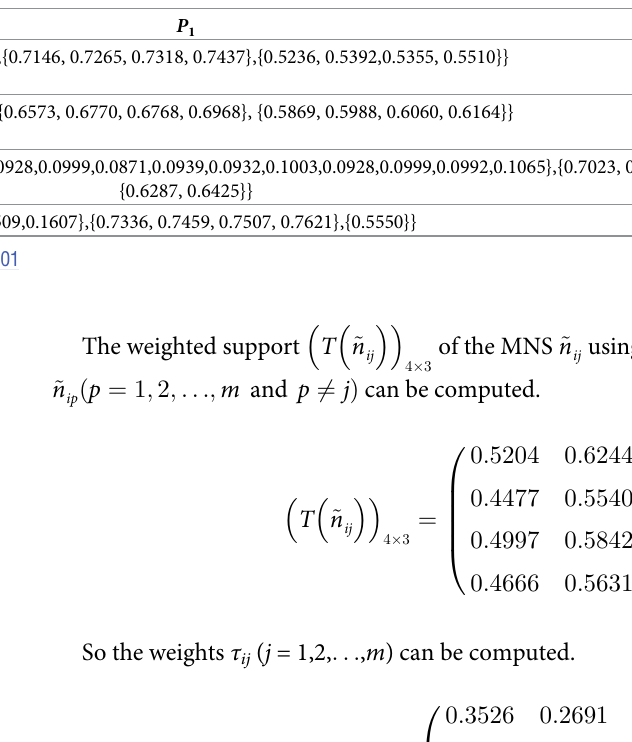
Table 1. The evaluation values of each alternate within partition of attributes.